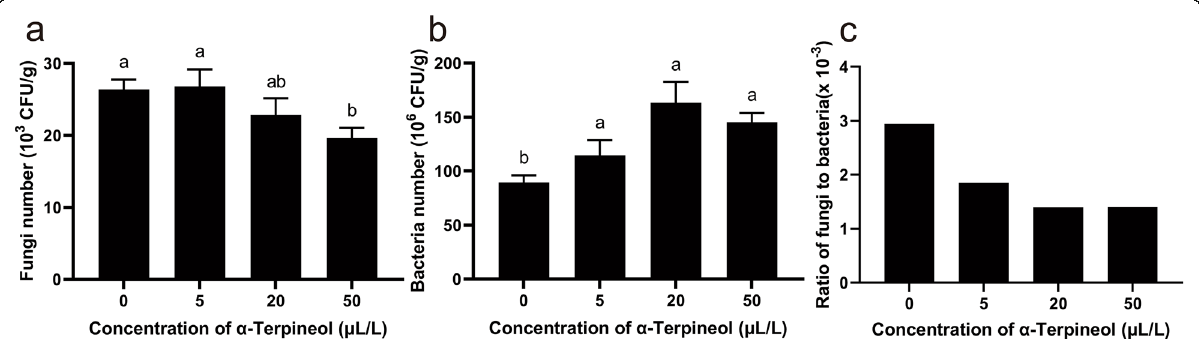
Fig. 3 Effects of α -terpineol fumigation on culturable fungi and bacteria in soil consecutively planted with Panax notoginseng . The numbers of culturable fungi ( a ) and bacteria ( b ) in soil fumigated with α -terpineol at concentrations of 0, 5, 20 or 50 μ L/L. c The ratios of fungi to bacteria in soil fumigated with α -terpineol at concentrations of 0, 5, 20 or 50 μ L/L. CFU, colony forming unit. Data are presented as the mean ± SE, bars indicate SE, and different letters indicate significant differences analyzed by one-way ANOVA with Duncan ’ s multiple range test, P <